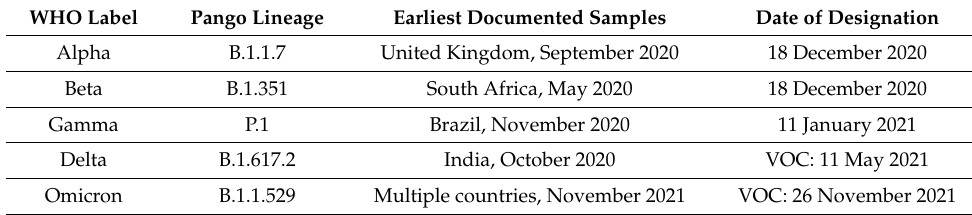
Table 1. Currently designated variants of concern (VOCs)+ by